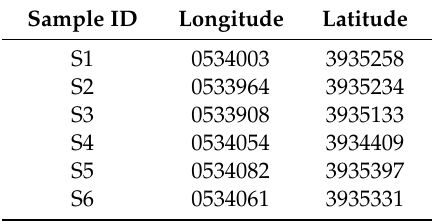
Table 3. Soil Samples locations for tetraethyl lead analysis at Sulaymaniyah Oil